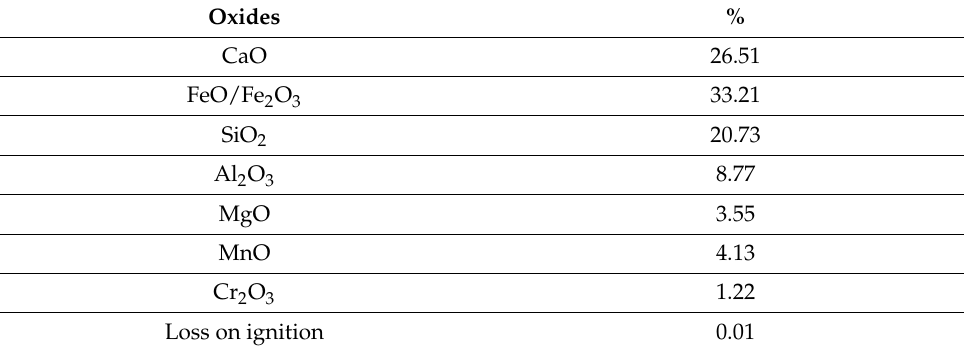
Table 5. Chemical analysis of